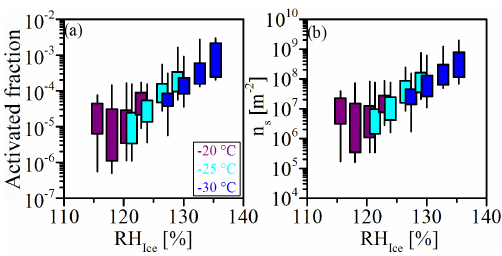
Figure 13. Activated fraction (AF) (a) and active site density n s (b) of aerosol particles larger than 0.5µm in diameter as a func- tion of ice supersaturation for Cruiser flights. The boxes represent the interquartile range. Vertical lines give the full range of observa- tions. The width of the boxes represents the uncertainty in humidity ( ± 1%).